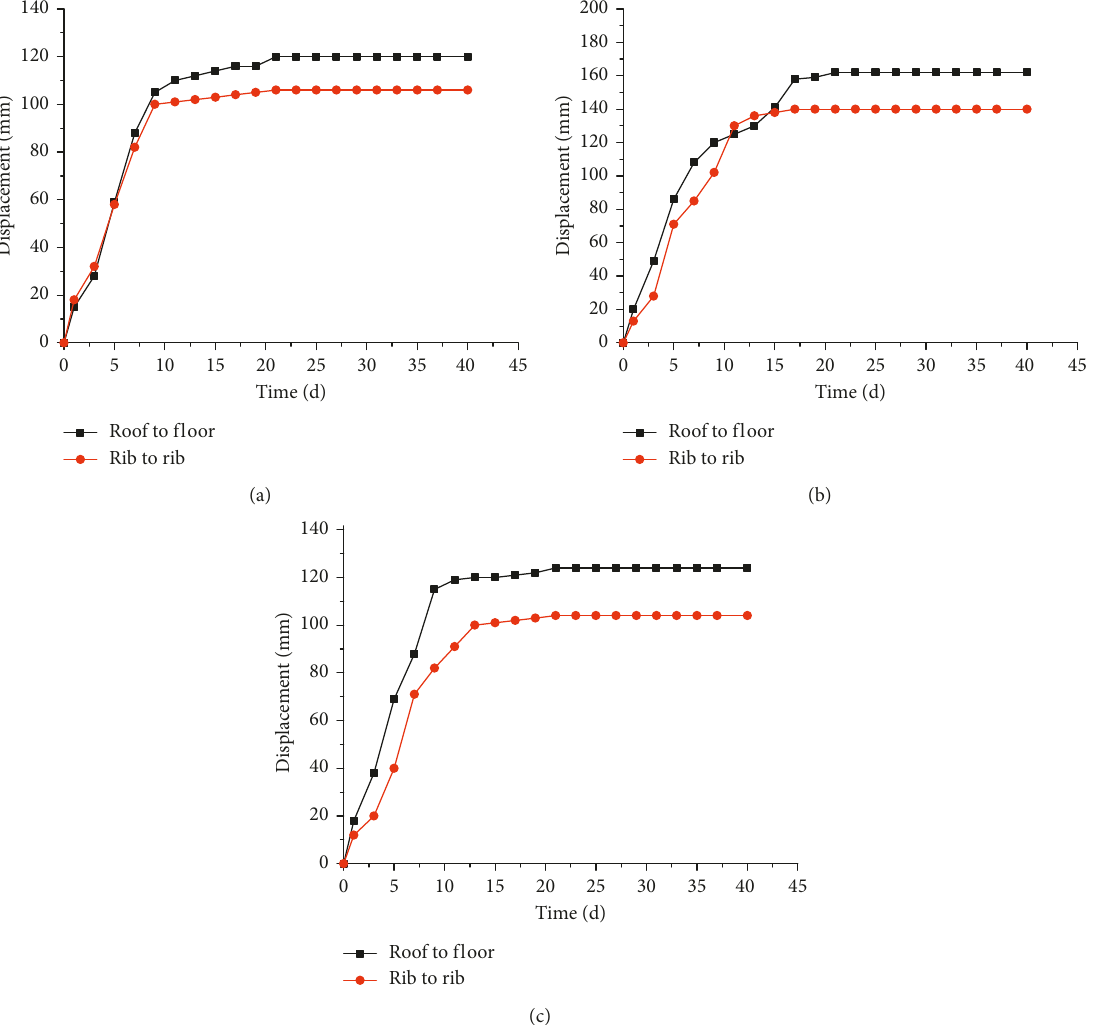
Figure 11: The surface displacement of the roadway: (a) monitoring station 1, (b) monitoring station 2, and (c) monitoring station